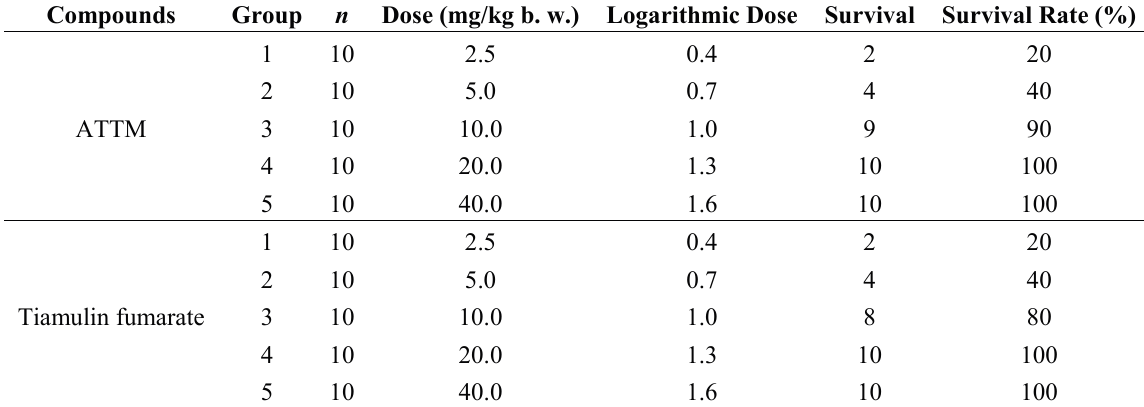
Table 1. Survival of mice challenged with MRSA after treatment with different doses of ATTM. Compounds Group n Dose (mg/kg b. w.) Logarithmic Dose Survival Survival Rate (%)